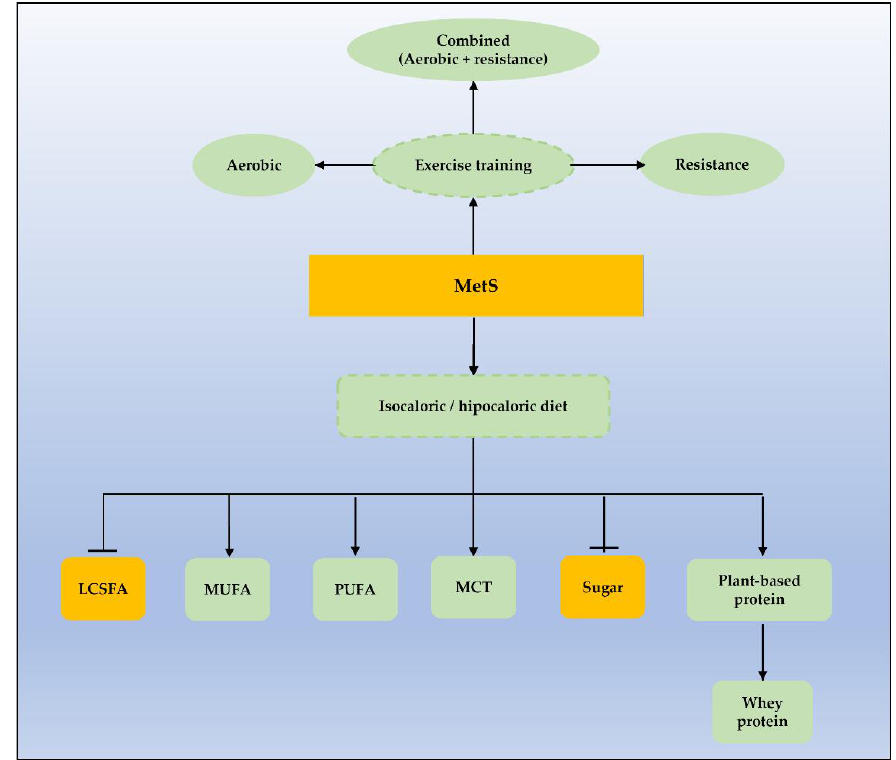
Figure 2. Dietary and exercise approaches targeting MetS. LCSFA, long-chain saturated fatty acids; MCT, medium-chain fatty acids; MUFAs, monounsaturated fatty acids, PUFAs, polyunsaturated fatty acids.